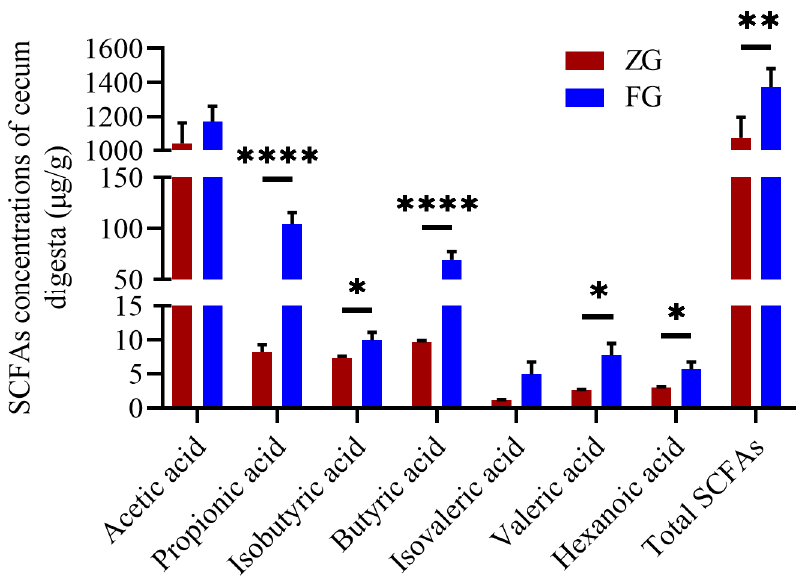
Figure 5. Differences in cecum total SCFA concentrations between the two goose breeds; n = 5. Vertical bars represent the mean ± SEM. * p < 0.05, ** p < 0.01, and **** p < 0.0001 indicate significant differences between the ZG and FG. ZG, Zi goose; FG, Xianghai flying goose; Total SCFAs, total short-chain fatty acids.